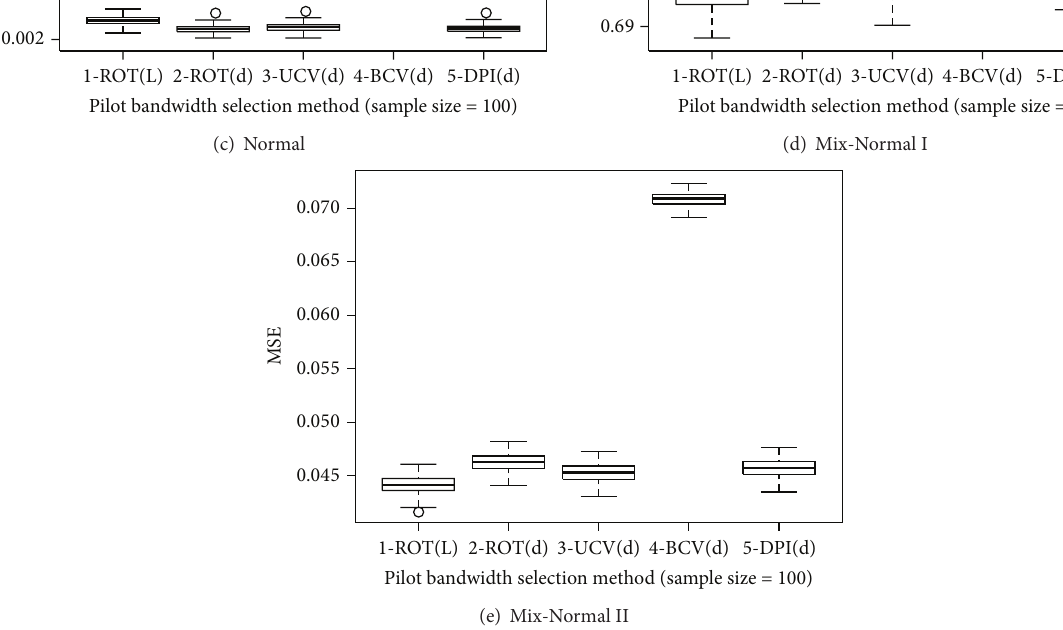
𝑔 for ̂ℎ ; “1-ROT(L)” means ̂𝑔 ; “2-ROT(d)” means ̂𝑔 DPI ;𝑈 2 ROT ;𝑈 2 ; “5-DPI(d)” means ̂𝑔 . BCV ; density DPI ; density